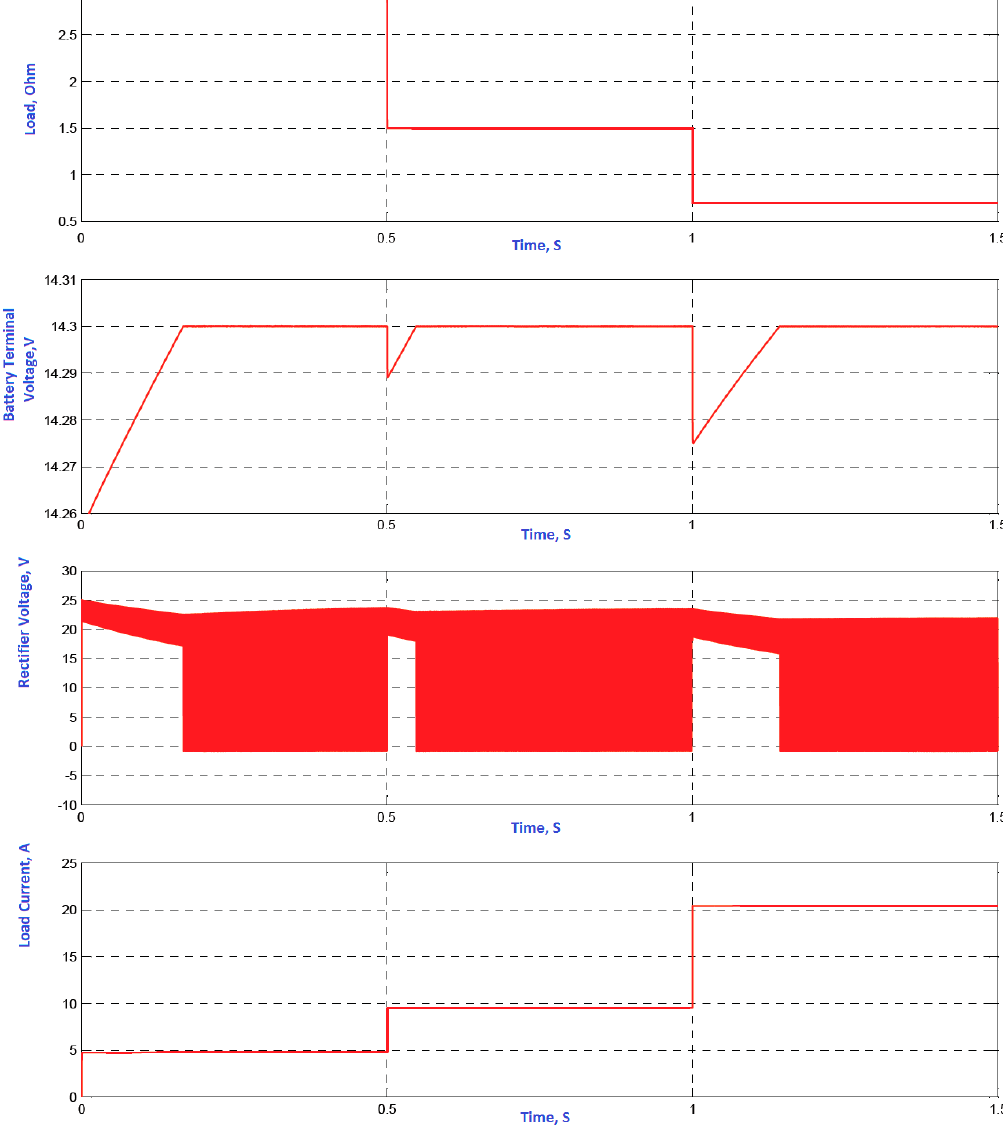
Figure 17. Simulation results for constant speed and variable electrical load.